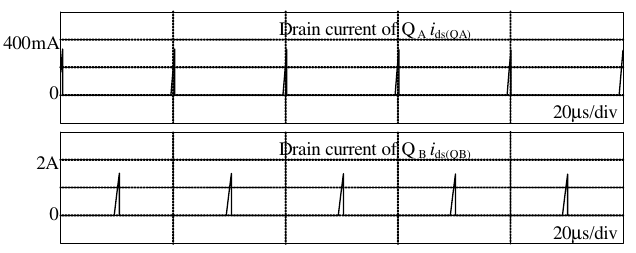
Figure 14. FFT analysis result when the average LED current is 15 mA.